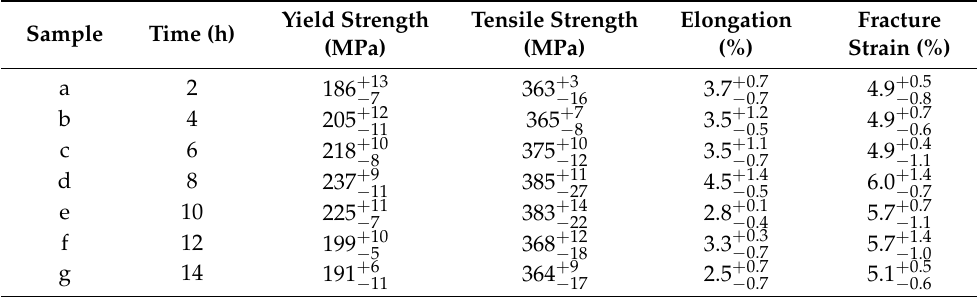
Table 4. Data of the tensile strength and fracture strain of Al-13Si-5Cu-2Ni alloy under different solid solution treatment times at 510 ◦ C.